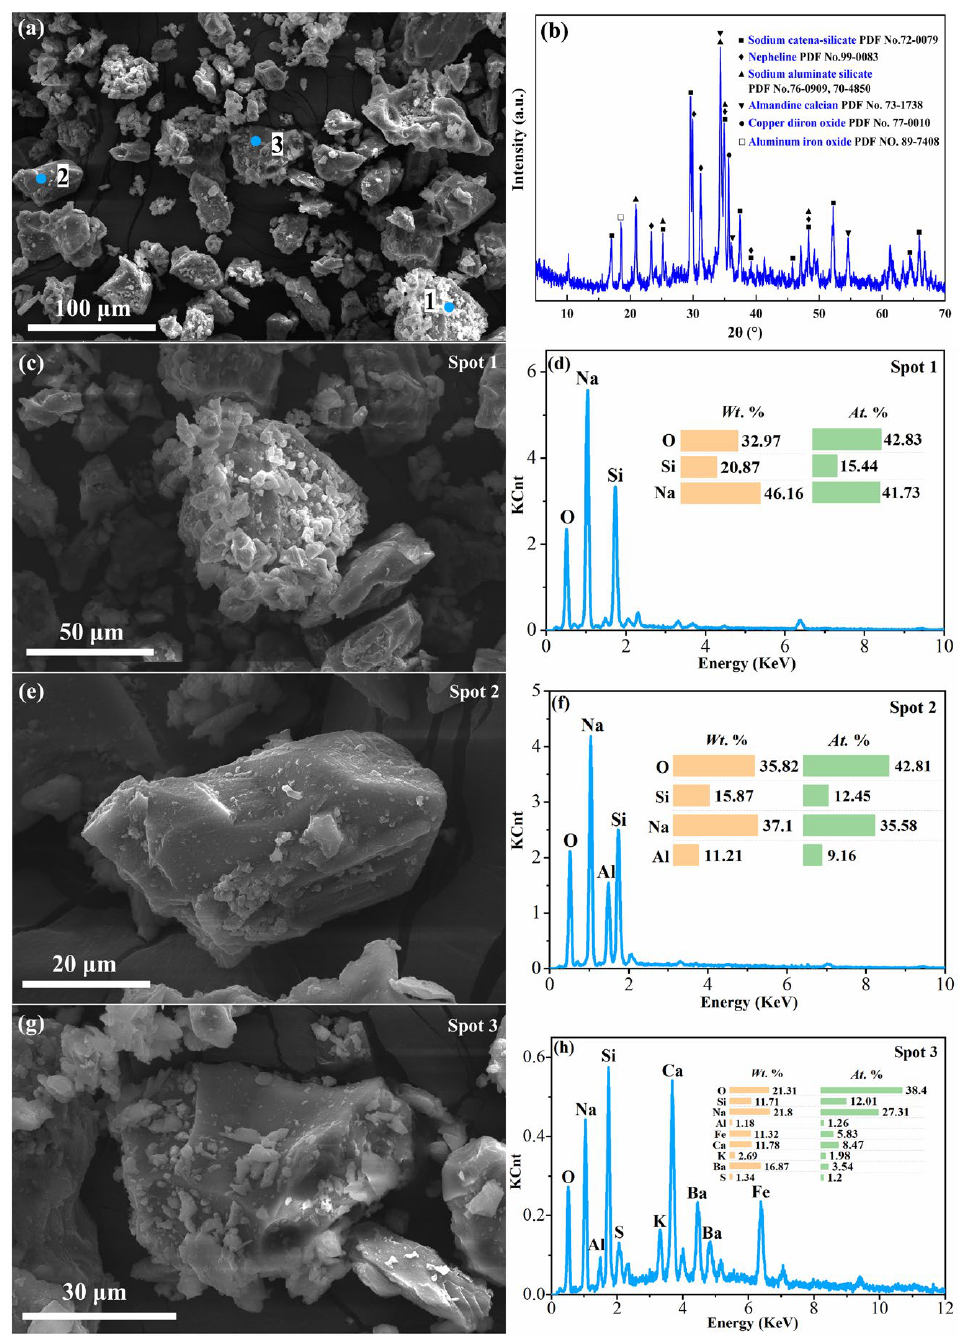
Figure 1. SEM images with EDS analyses and XRD pattern of silver tailings’ roasted clinker: ( a ) SEM image and ( b ) XRD pattern of silver tailings roasted clinker; ( c ), ( e ) and ( g ) enlarged images and ( d ), ( f ) and ( h ) EDS analyses of Spot 1, Spot 2 and Spot 3, respectively, in Figure 1a.